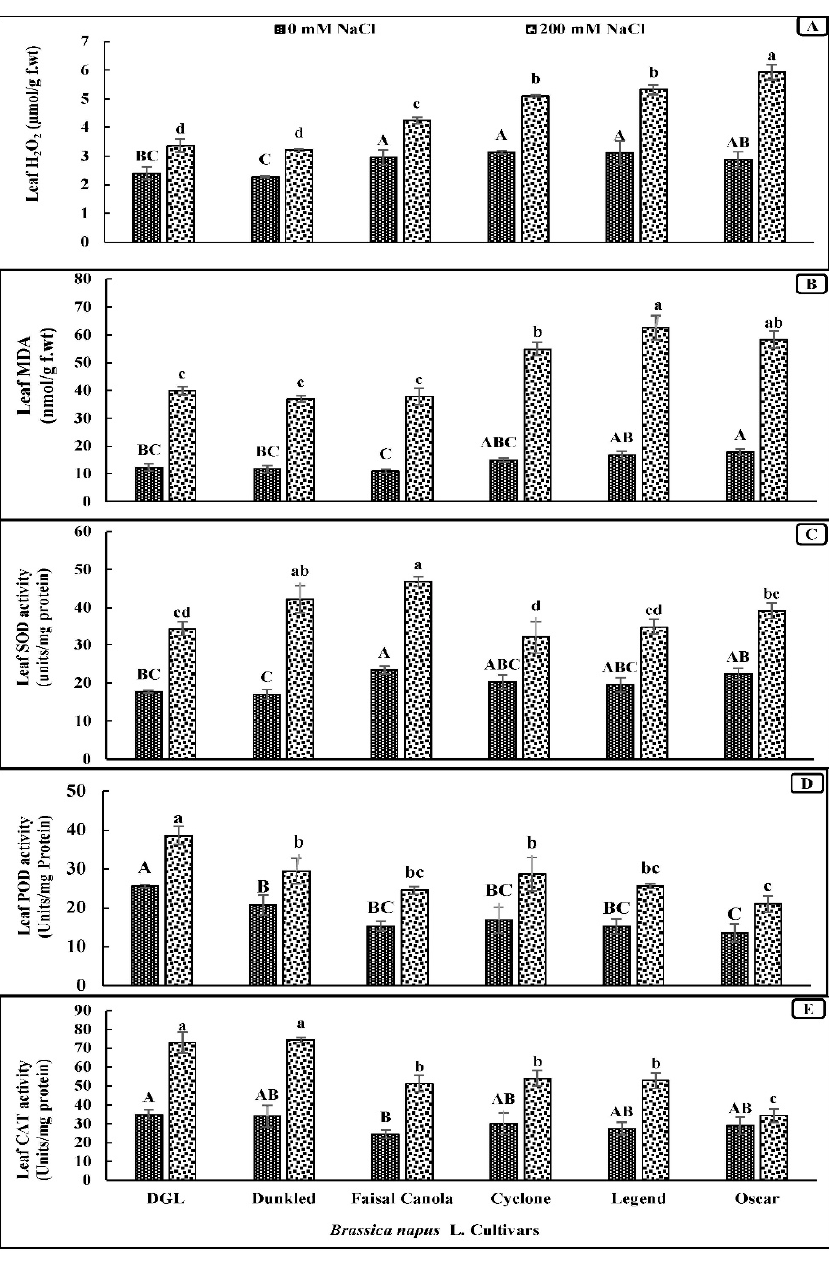
Figure 2. Production of ROS and antioxidative enzyme activity in the leaves of canola cultivars when three-week-old plants were subjected to salt stress (0 m M and 200 m M NaCl). ( A ) Leaf H 2 O 2 . ( B ) Leaf MDA. ( C ) Leaf SOD. ( D ) Leaf POD. ( E ) Leaf CAT activity. n = 4. Means were compared with LSD 0.05 of the interaction term (Salinity × Cvs) only. Means with the letters (A–B) for control and (a–b) for saline differed significantly at 5% probability.